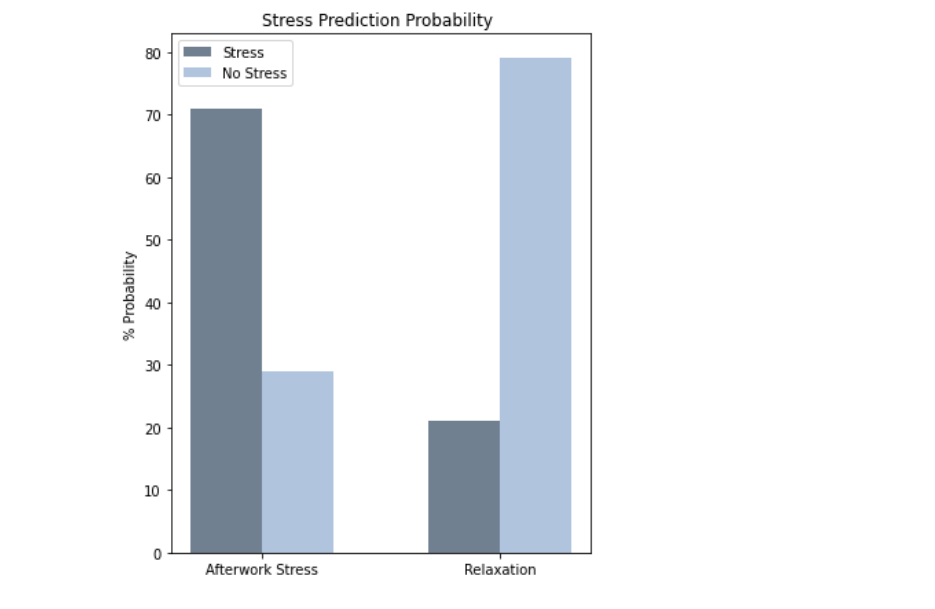
Figure 9. Mean Prediction Probability obtain from the stress detection app with volunteers input data, who were subjected to different stress conditions (after work stress and relaxation).